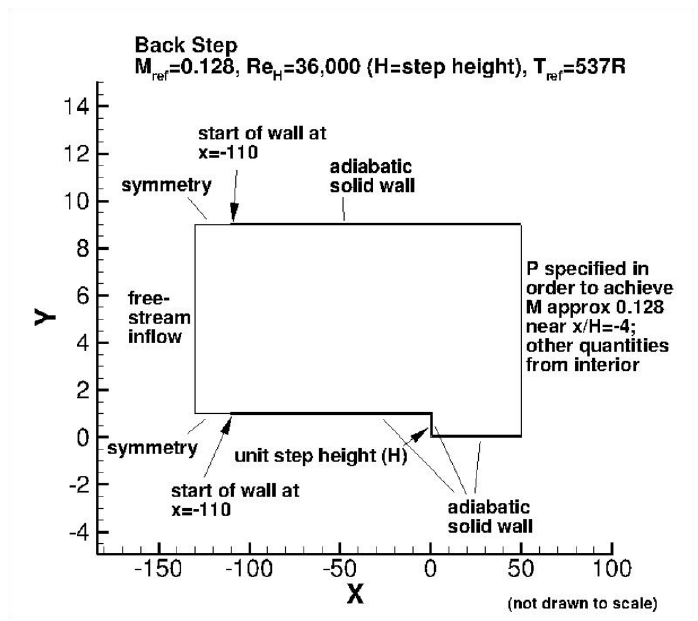
Figure 17. Backward-facing step geometry and boundary conditions